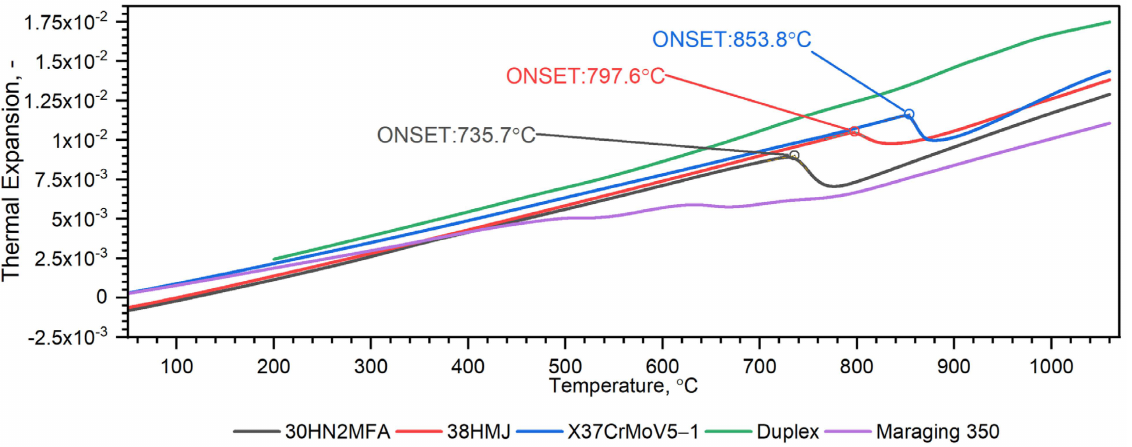
Figure 20. Comparison of thermal expansion characteristics as a function of temperature for